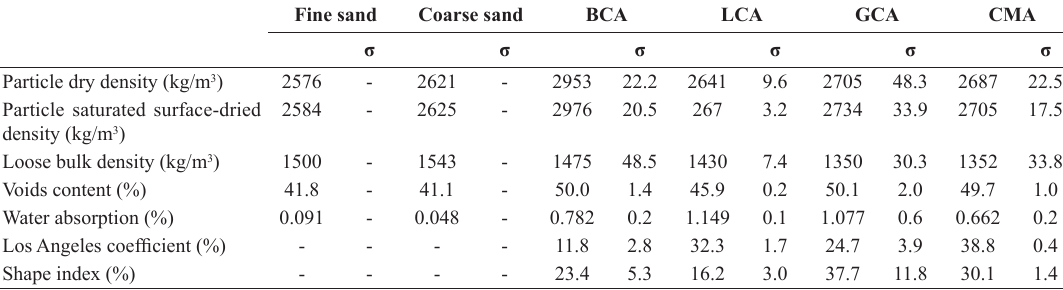
Table 3. Aggregates’ properties (average and standard